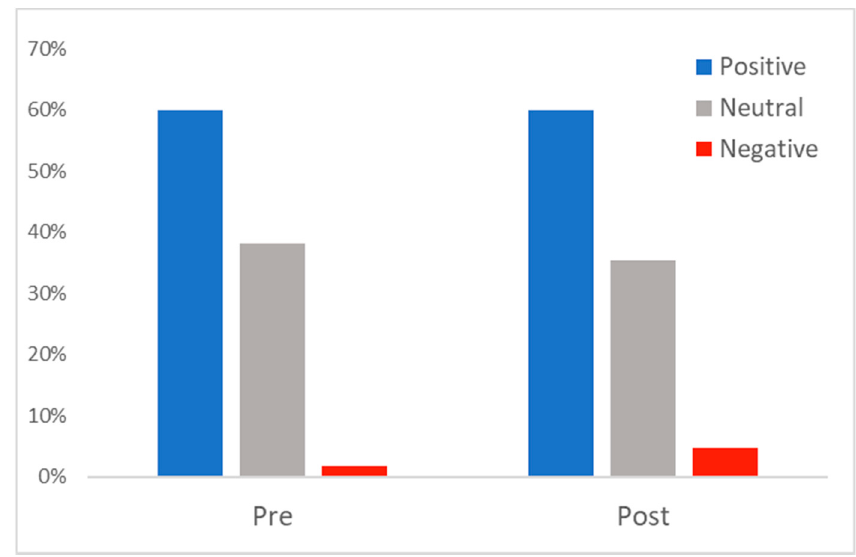
Figure 3. Consumer sentiment of tweets analyzed pre- and post- 1 March 2020.